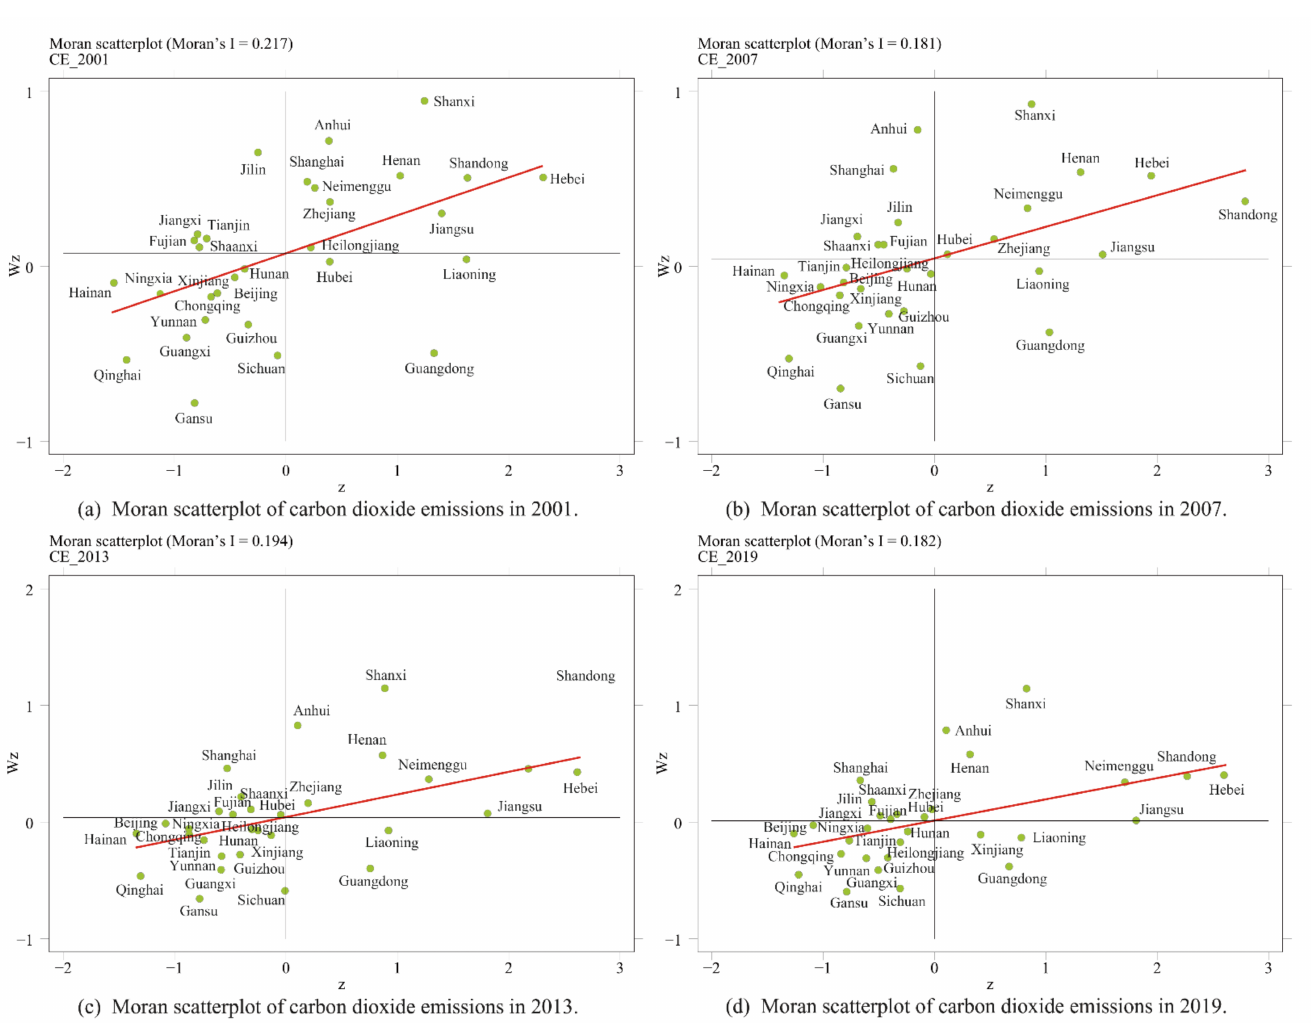
Figure 6. Moran scatterplot of carbon dioxide